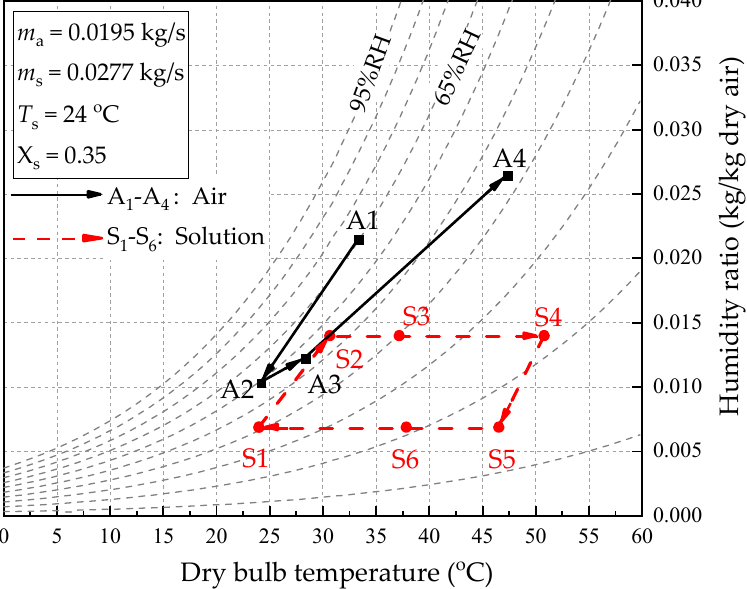
Figure 5. The psychrometric diagram of the air and solution streams in the dehumidi fi er system.